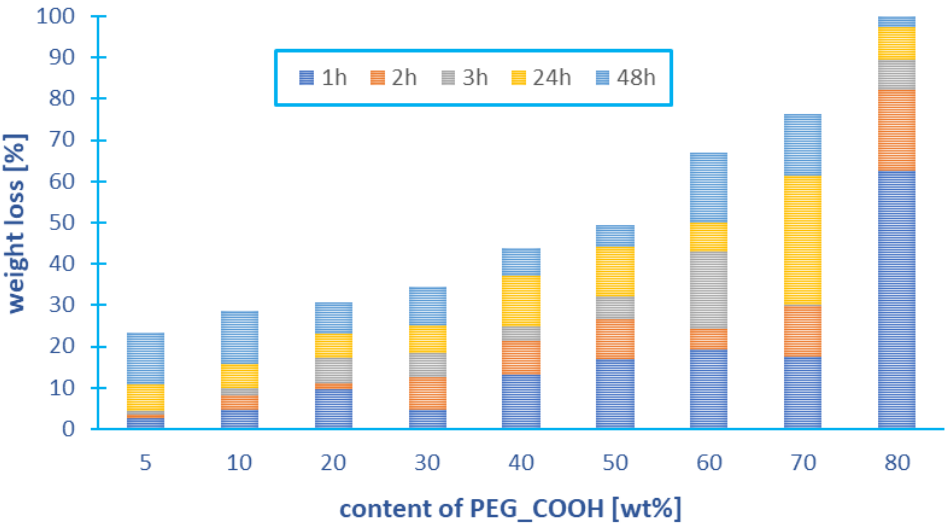
Figure 9. Weight loss of branched copolymers based on DBB and PEG_COOH during hydrolytic degradation in phosphate buffer conducted at 37 °C (Experiments were performed in triplicate).